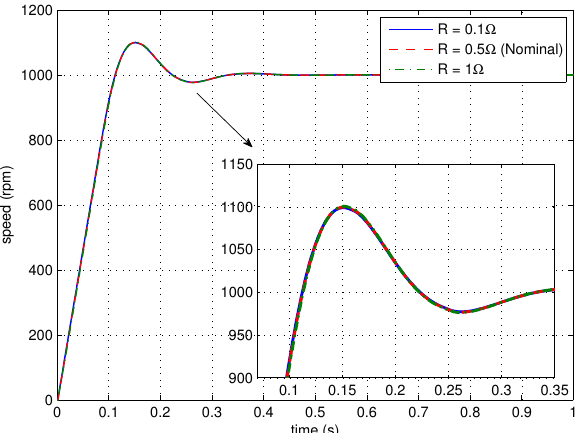
Figure 4. Tests of robustness to stator resistance